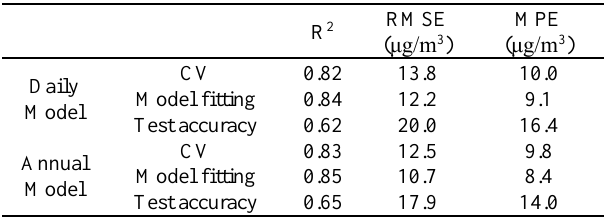
Table 1. Performance of PM 2.5 estimation models The PM 2.5 estimates were evaluated using 10-fold CV method.